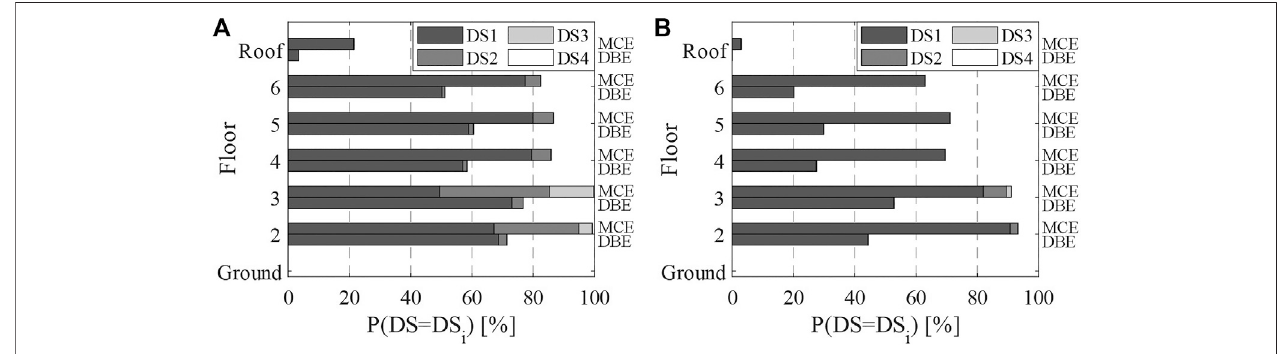
FIGURE 13 | Probability of attaining each damage state along the height of the composite steel MRF; at DBE and MCE seismic intensities. (A) Full dataset (B) Suzuki and Kimura (2019) subset